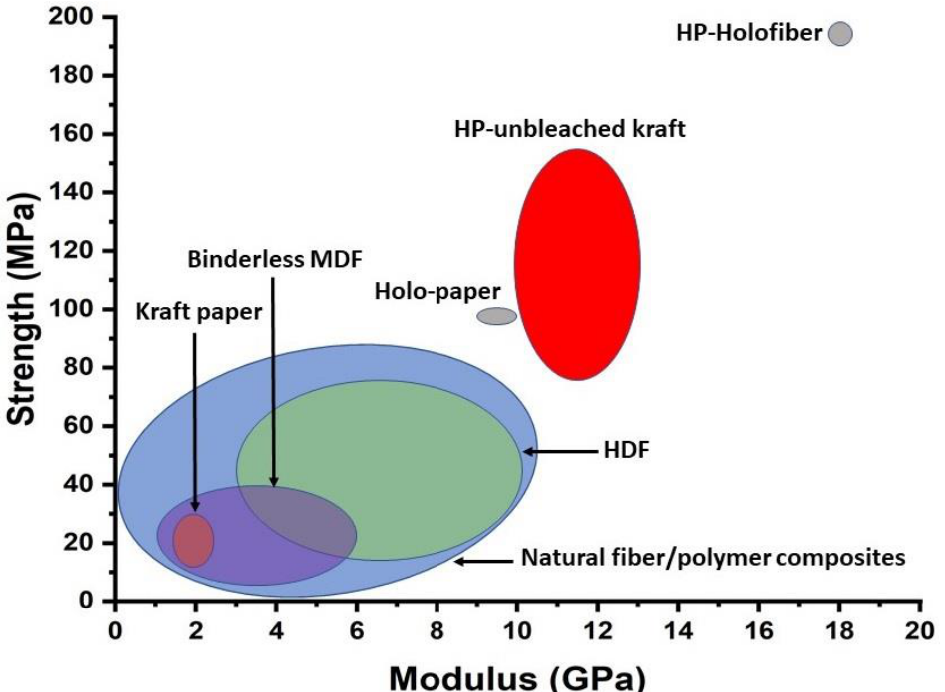
Figure 2. Strength vs. modulus Ashby plots for fiber materials (data for 2D-random materials from Table 1; data for natural fiber/polymer 2D and 3D-random composites from [51] ).